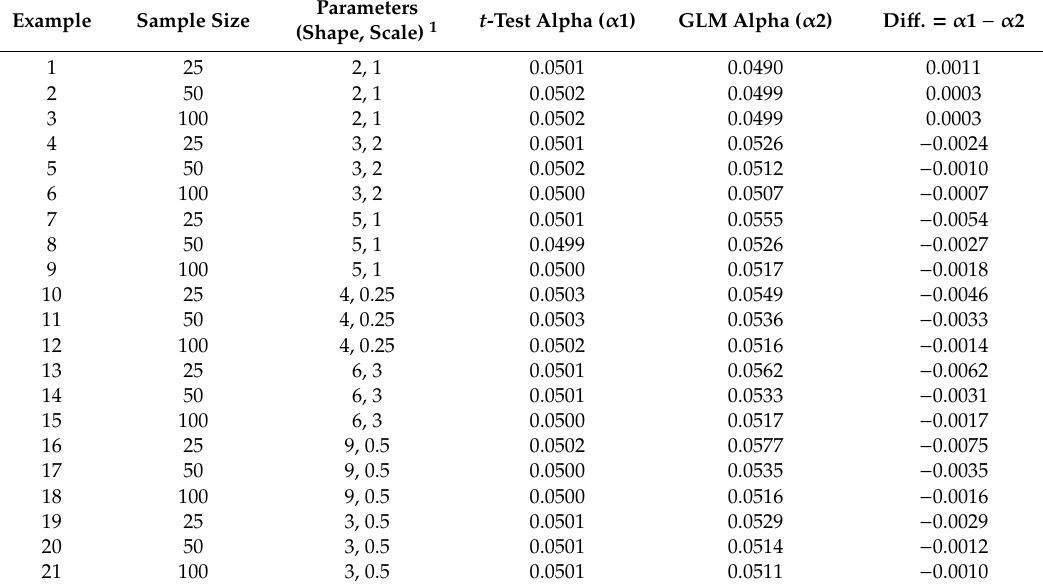
Table 1. Alpha values for gamma-distributed data tested using t -test and GLM.